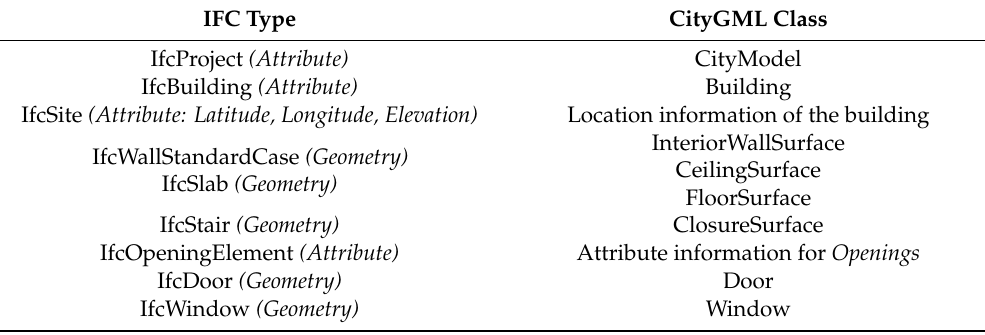
Table 1. Semantic mappings from Industry Foundation Classes (IFC) to CityGML.